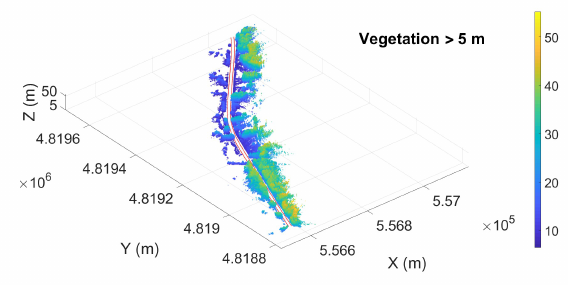
Figure 8. Vegetation points with greater height than 5 m.